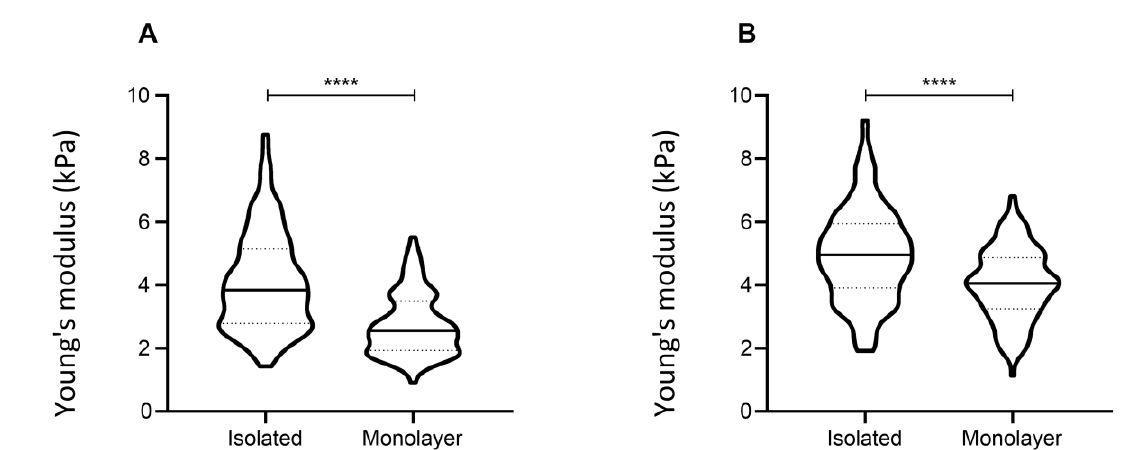
Figure 11. Contribution of cell confluence. Distribution of the single-cell Young’s Modulus, from two different fibroblast lines (lines 2 ( A ) and 4 ( B )). The statistical analysis is on a non-parametric Kolmogorov–Smirnov test (**** p < 0.0001).